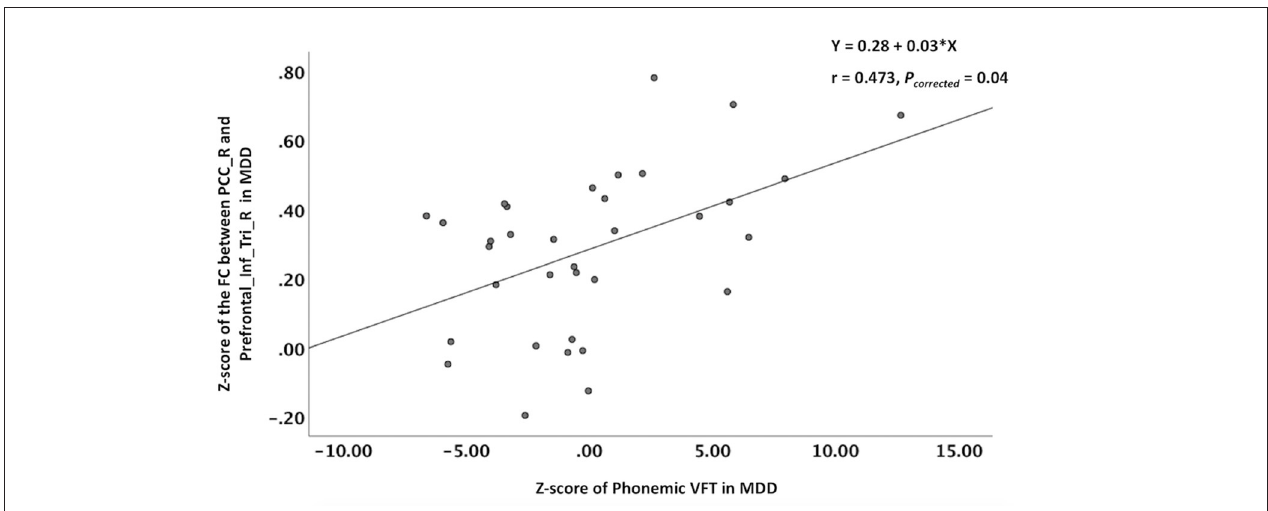
FIGURE 2 | Correlations between altered z-score of the FC and the z-score of the VFT. The phonemic VFT score was positively correlated with the z-score of the FC between the right PCC and the right inferior frontal gyrus (triangular part). VFT, verbal fluency test; PCC_R, right posterior cingulate cortex; Prefrontal_Inf_Tri_R, right inferior frontal gyrus (triangular